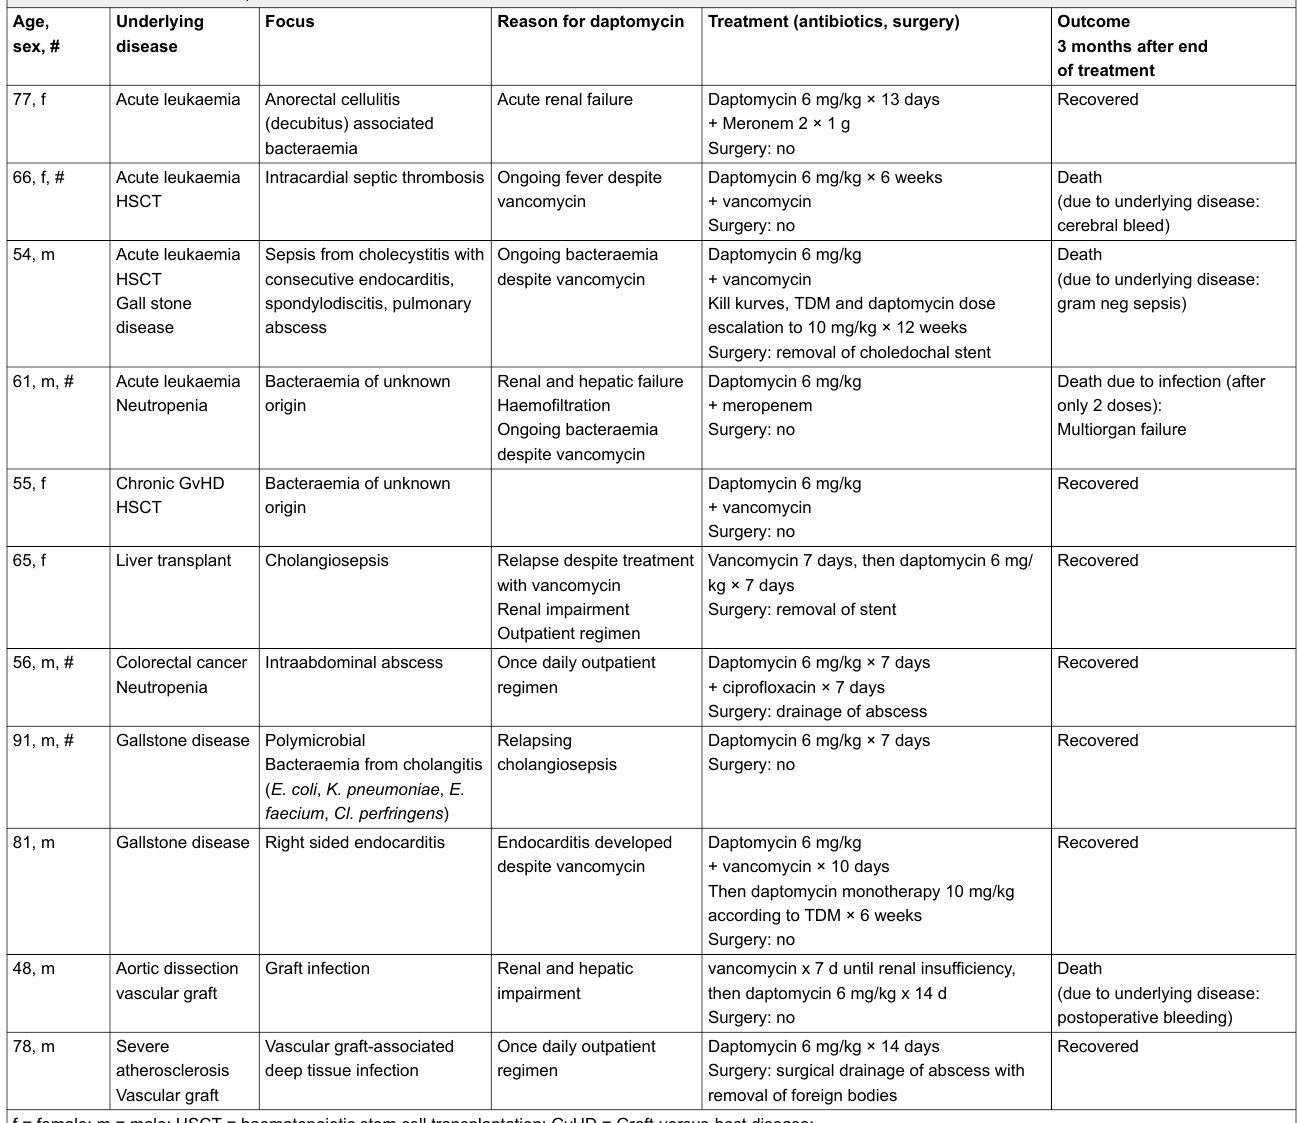
Table 1: Patient characteristics, antibiotic treatment and outcome. Age, sex,